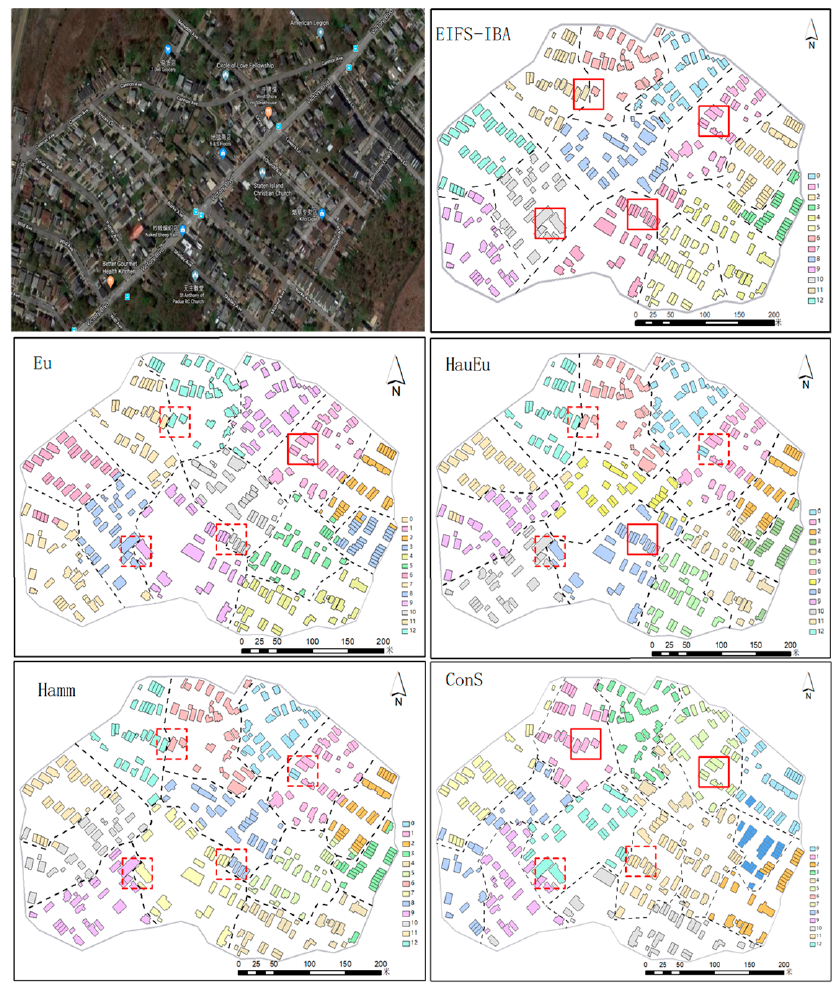
Figure 9. Clustering results of different similarity approaches. Table 6. The silhouette coefficient of cluster region c .